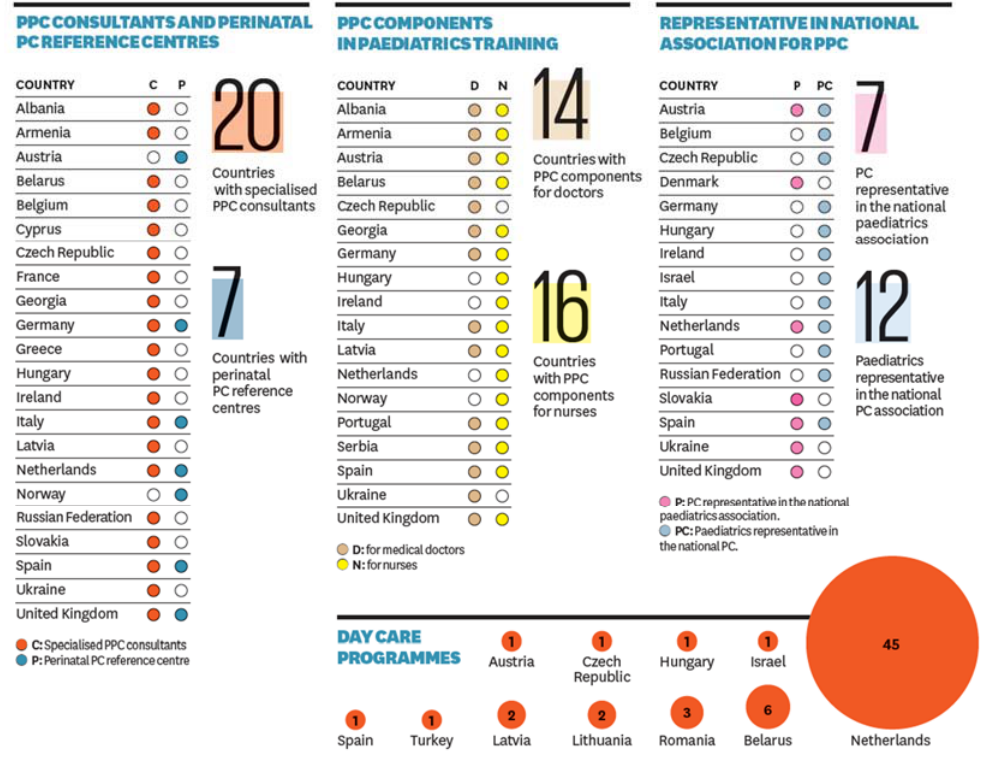
Figure 1. Paediatric palliative care development in Europe [6].